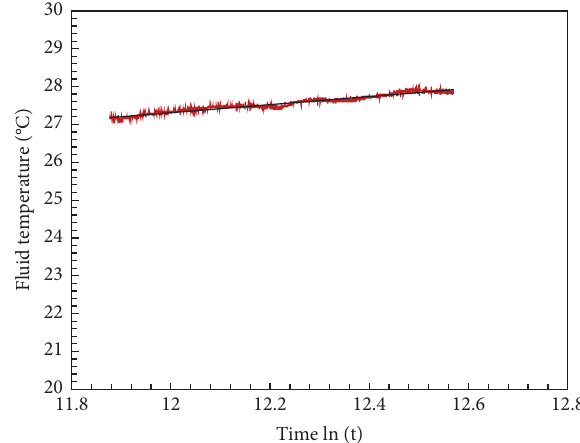
Figure 3: Te variation of carrying fuid temperature with time to get the ground thermal